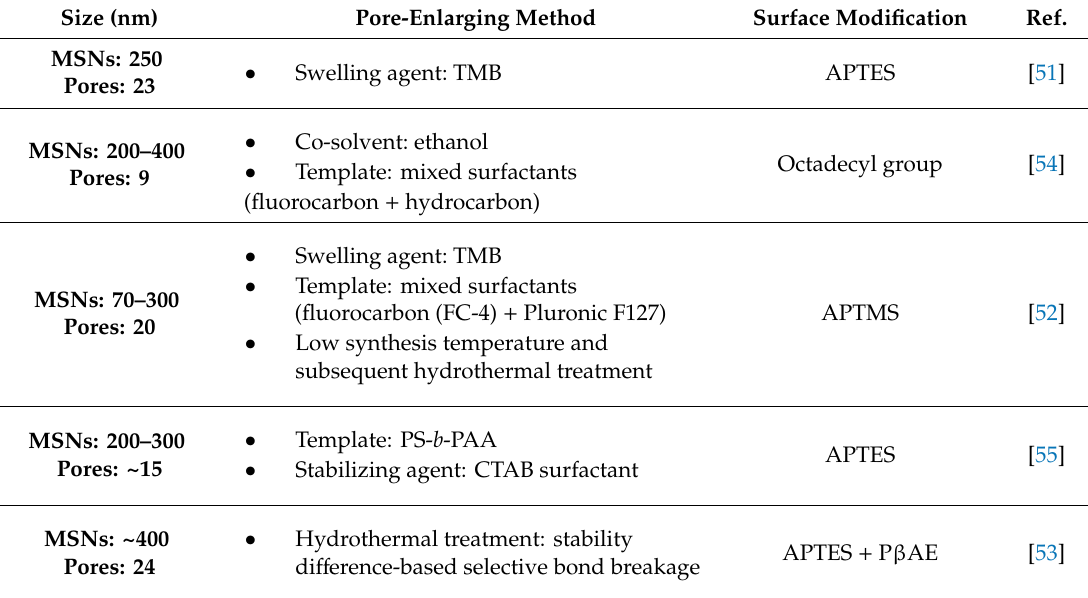
Table 2. Examples of di ff erent approaches reported for the obtention of large-pore sized MSNs. Size (nm) Pore-Enlarging Method Surface Modification